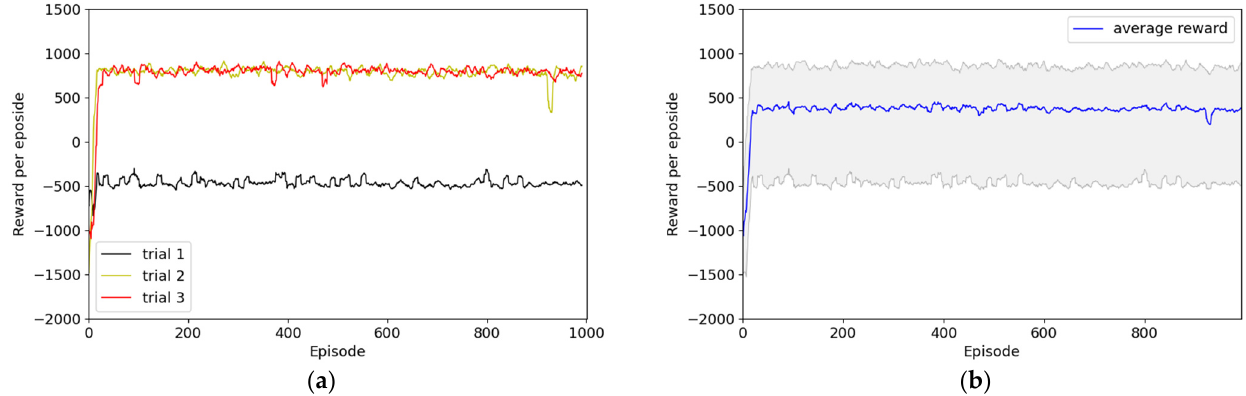
Figure 10. Results of Experiment 2: reward system applied with sufficient reward engineering without HER. ( a ) Episode rewards for each of the three trials; ( b ) maximum, minimum, and average values of episode rewards considering all three episodes.